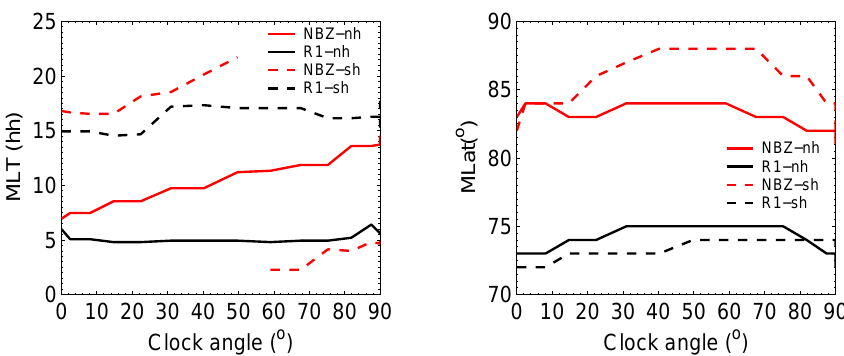
Fig. 6. Variation of the location of the peak FAC densities with the changing clock angle. The solid lines denote the Northern Hemisphere variations and the dashed lines those of the Southern Hemisphere. Red is used for NBZ FACs and black for R1 FACs. Left is the local time evolution of the peak NBZ and R1 FACs in both hemispheres. Right is the MLat evolution of the peak NBZ and R1 FACs.